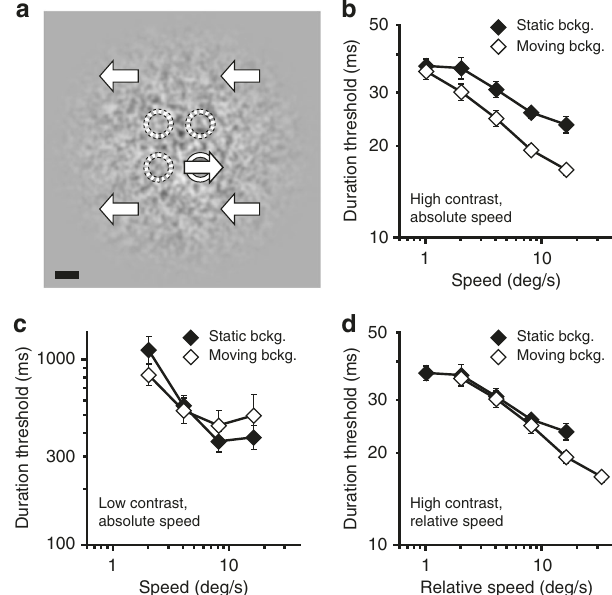
Fig. 2 Motion segregation on moving and static backgrounds. a Observers identi fi ed the location of a moving target which could occur in one of four possible locations (shown with dotted circles for illustration purposes only). The target background was either moving (as illustrated) or stationary. Scale bar is 2°. b Effects of speed on task performance for moving and static backgrounds at high contrast. c Same as ( b ), but at low contrast. d Same data as in ( b ), but with speed expressed as relative to the background. Error bars are s.e.m.